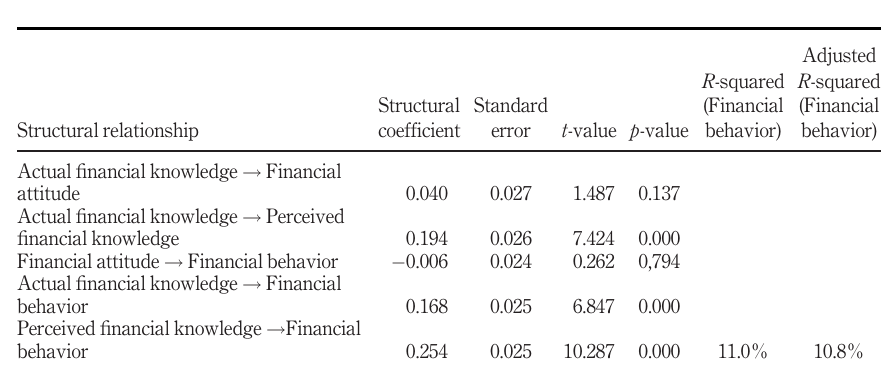
Table V. Structural Model 2 –